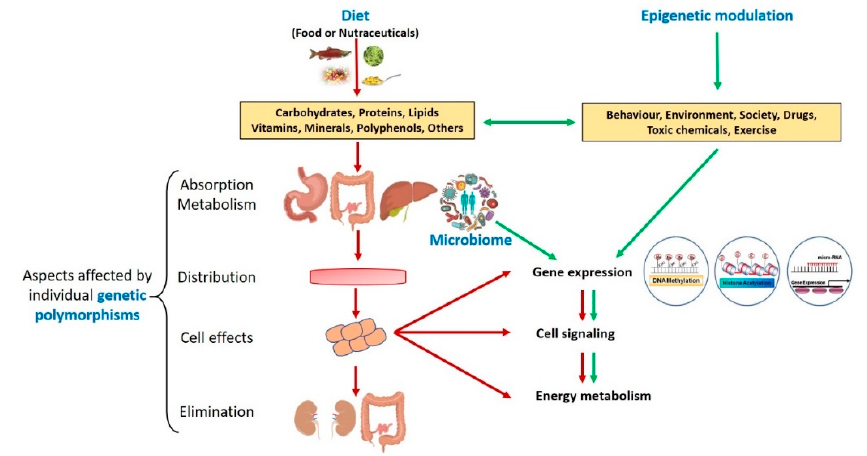
Figure 1. A new holistic view of nutrition with a focus on phytonutritional epigenomics: Influence of genetic mutations, epigenetic modulation, and the gut microbiome (for figure description, see the text).